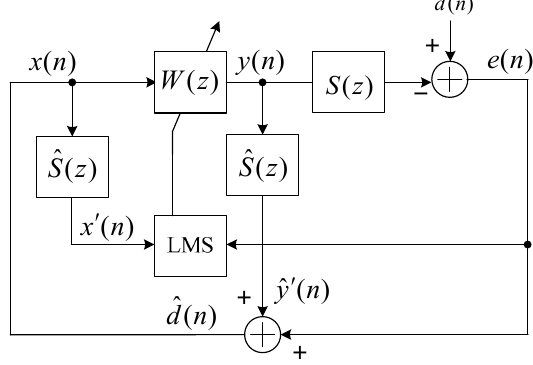
Figure 1. Block diagram of a typical adaptive feedback ANC system using the FXLMS.